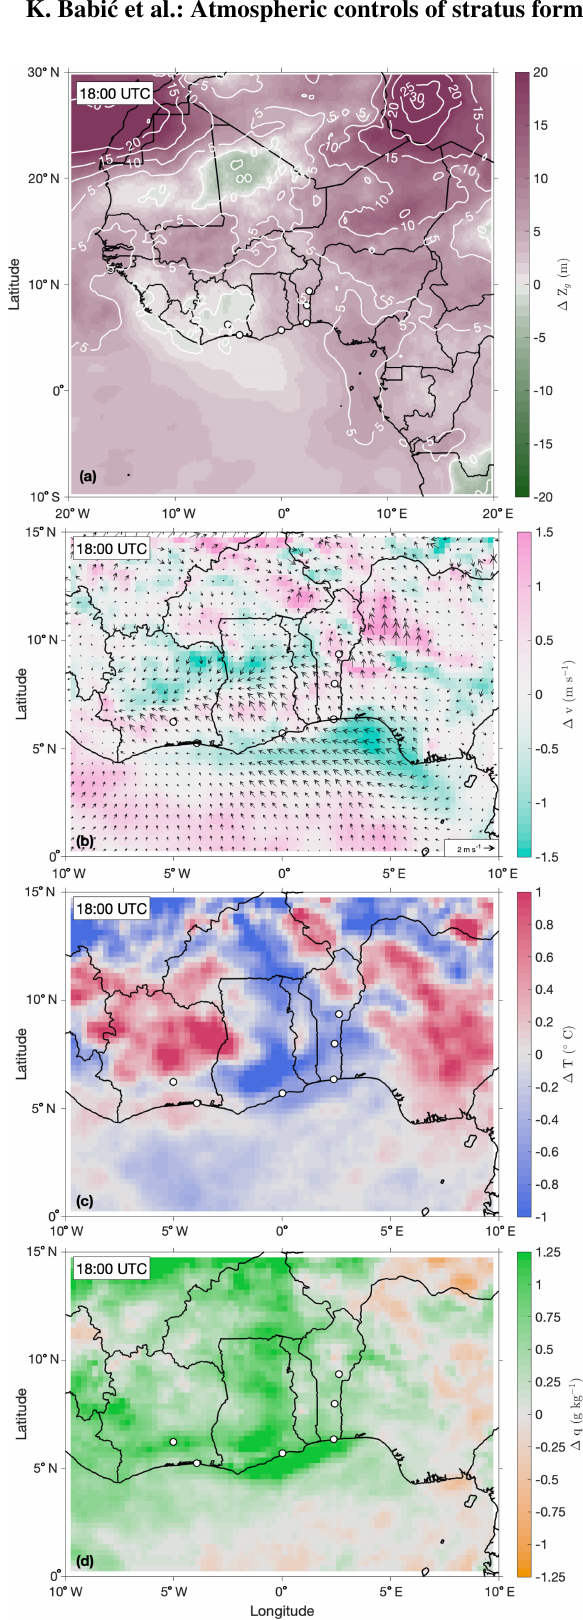
Figure 11. The differences between stratus-stratus-free nights in (a) geopotential height (color and white isolines), (b) wind speed (color) and wind vectors (arrows), (c) temperature, and (d) specific humidity at 950hPa isobaric level at 18:00UTC from ERA5 reanalysis. Please note that horizontal wind vectors are plotted at every other grid